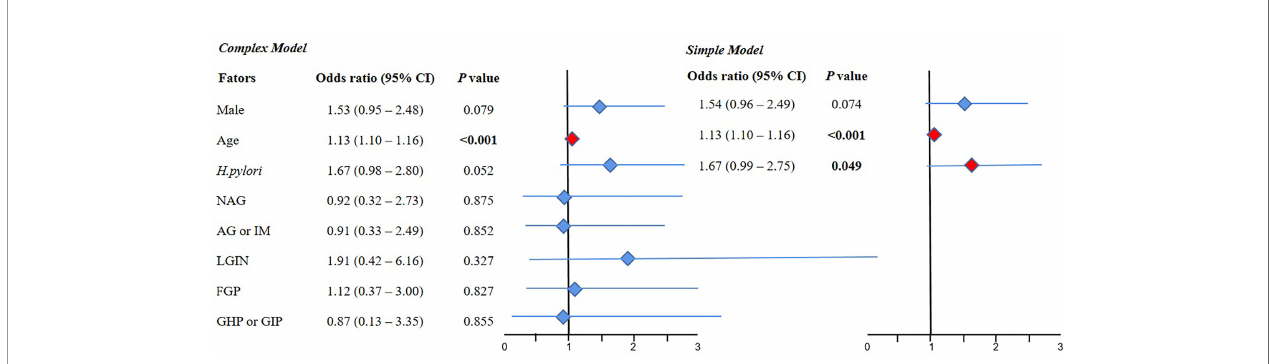
FIGURE 4 | The result of multivariate logistic regression for the CRC group compared with the normal group. 95% CI, 95% con fi dence interval; NAG, non-atrophic gastritis; AG or IM, atrophy/intestinal metaplasia; FGP, gastric fundus gland polyps; GHP or GIP, hyperplastic/in fl ammatory gastric polyps; LGIN, low-grade intraepithelial neoplasia. Complex model: All variables were included, and then P values were calculated separately. Simple model: Based on the complex model and the stepwise regression method, an optimal simple model is obtained, which is automatically screened according to the Akaike information criterion (AIC) minimization principle.